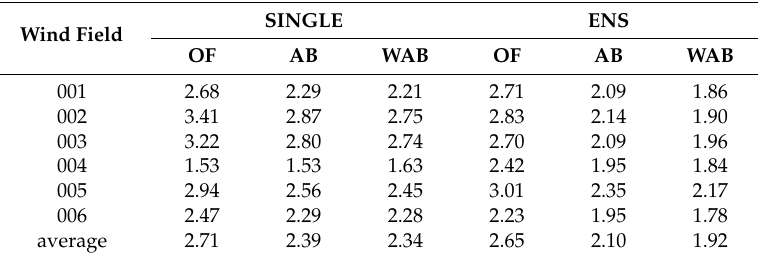
Table 2. Daily average RMSE (m/s) of six predictions, including original forecasts (OF), average bias correction (AB), and weather adapted bias correction (WAB) results of the single member predictions (SINGLE) and the ensemble predictions (ENS).